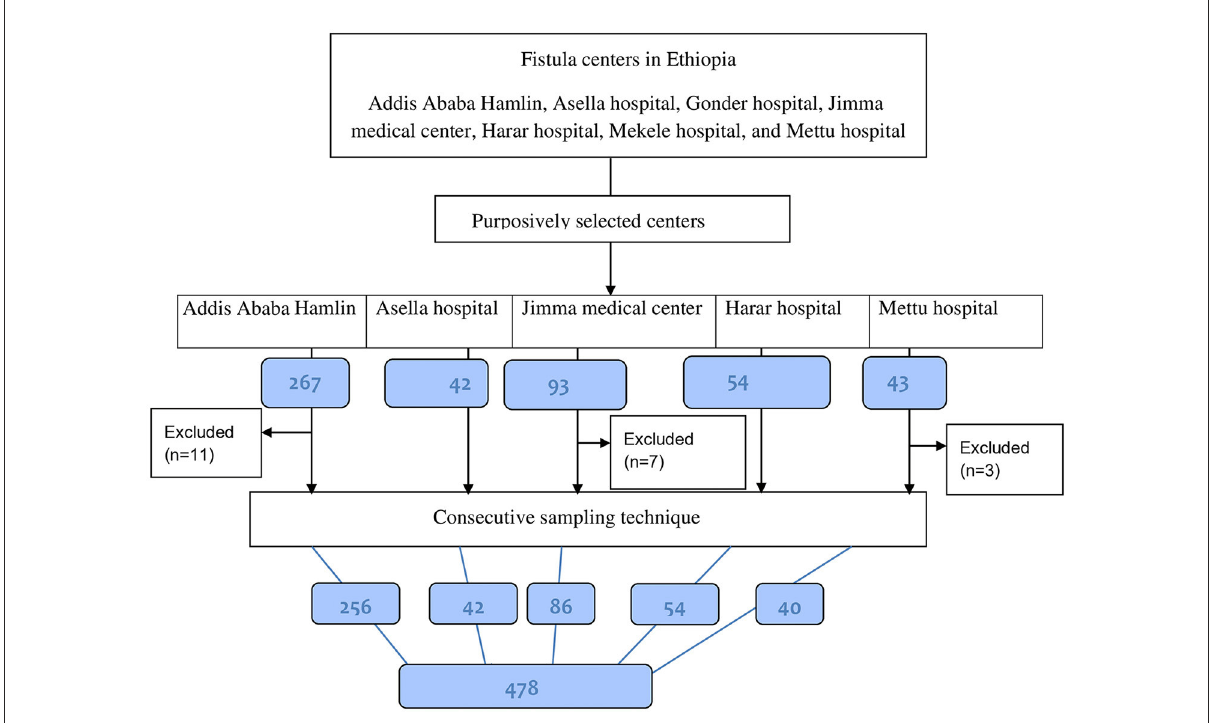
FIGURE1 Diagrammatic representation of the sampling